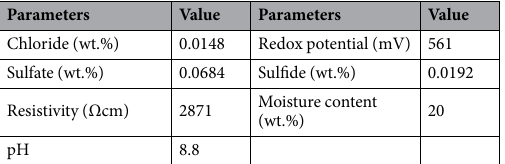
Table 2. Main parameters of the soil as received from the field in Tianjin (northeastern